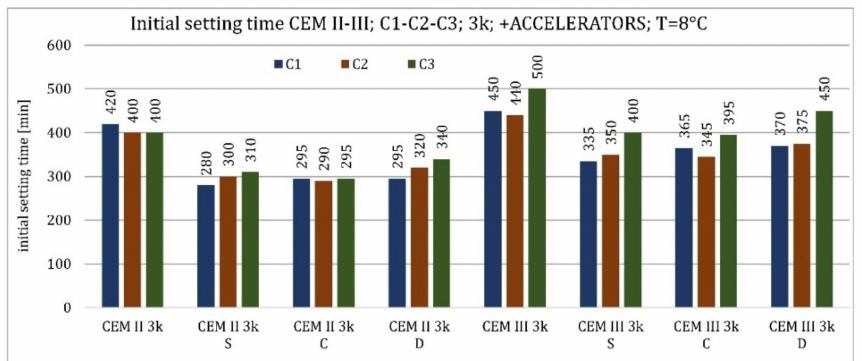
Figure 8. Initial setting time of cements CEM I, CEM II/B-S, CEM III/A modified with accelerators at 20 ◦ C.